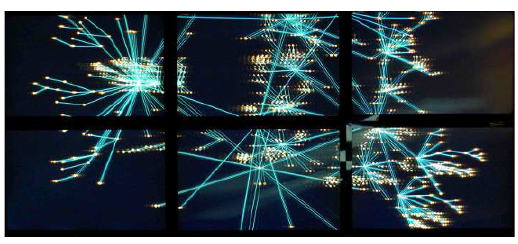
Figure 20. Too much z-depth in the model causes ghosting. Con- tent from the “How Much Information” project, Andrew Prudhomme. Photo: Tom DeFanti. (Autostereo not turned off.)